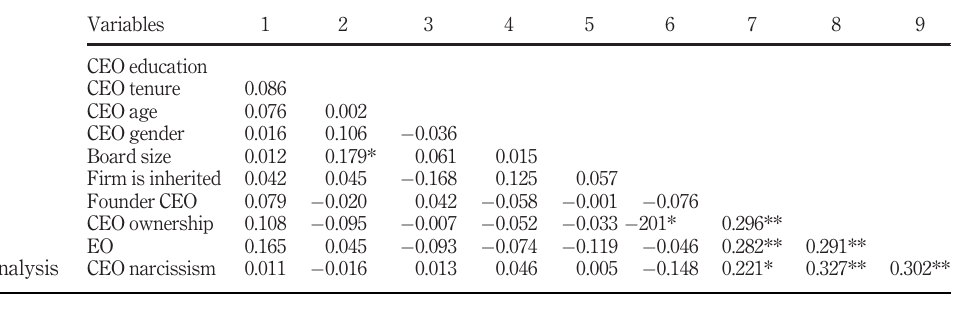
Table III. Correlation analysis